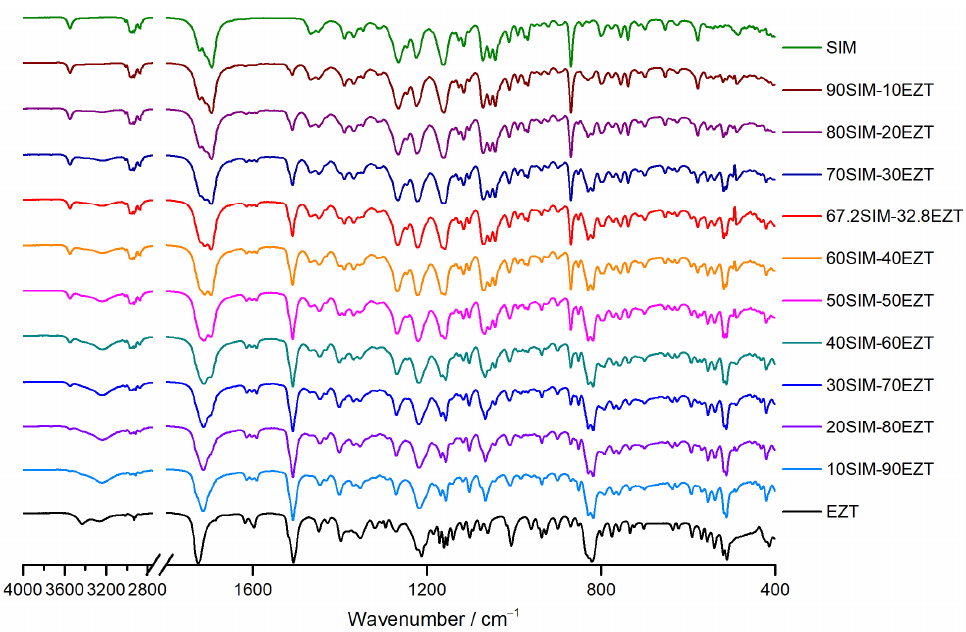
Figure 6. FTIR spectra of pure ingredients (SIM, EZT) and SIM-EZT SDs.